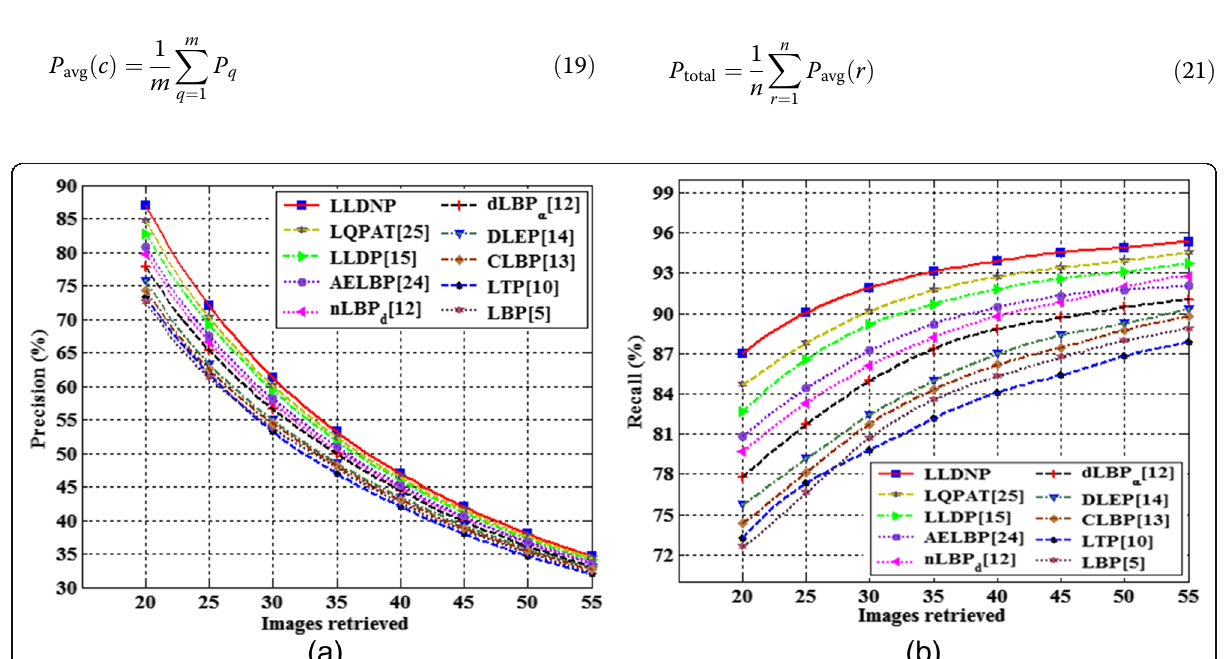
Number of relevant images retrieved Total number of relevant images in the database where q represents identifier related to database image.